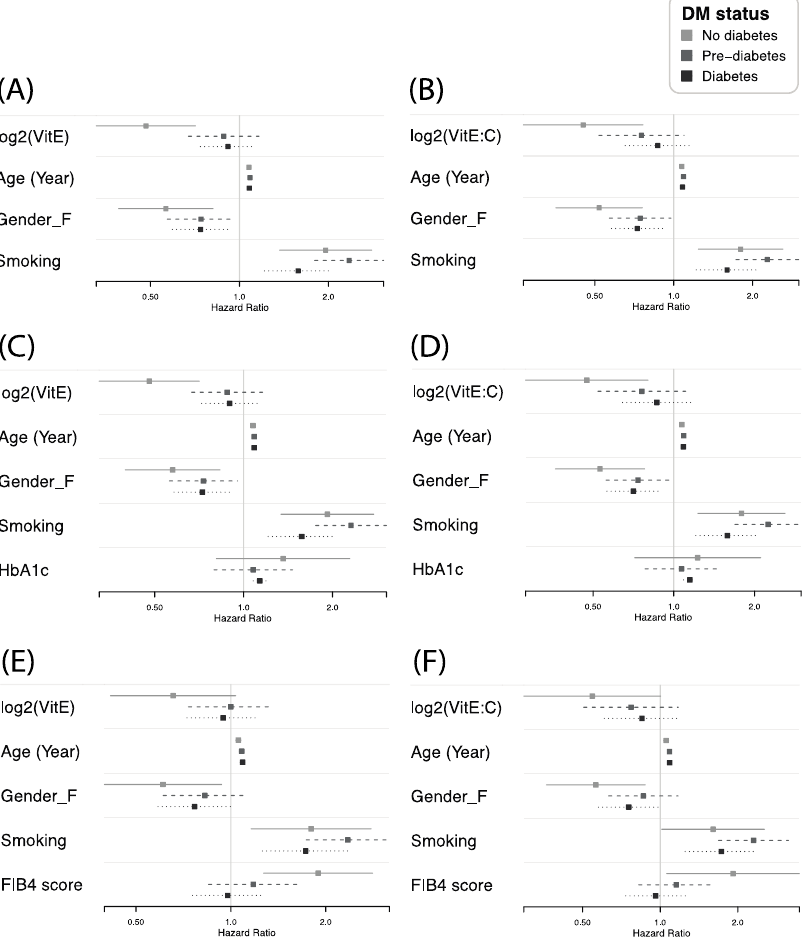
Figure 1. Comparison of hazard ratios in 3 diabetic status groups of serum vitamin E ( A, C, E ) or vitamin E: cholesterol ratio ( B, D, F ) with various models adjusting for potential contributing factors on all-cause mortality. ( A ) Serum vitamin E ( B ) serum vitamin E: cholesterol ratio was inversely correlated with mortality only in non-diabetic group ( C ) Serum vitamin E as well as ( D ) serum vitamin E:cholesterol ratio was inversely correlated with mortality only in non-diabetic group, while HbA1c is positively associated with higher risk only in diabetic group ( E,F ) FIB4 score was positively correlated with mortality only in non-diabetic group. The effect of serum vitamin E ( E ) or lipid-corrected vitamin E level ( F ) on mortality decreases while FIB4 score was added as a covariate in the model (compare A vs. E , and B vs. F ).